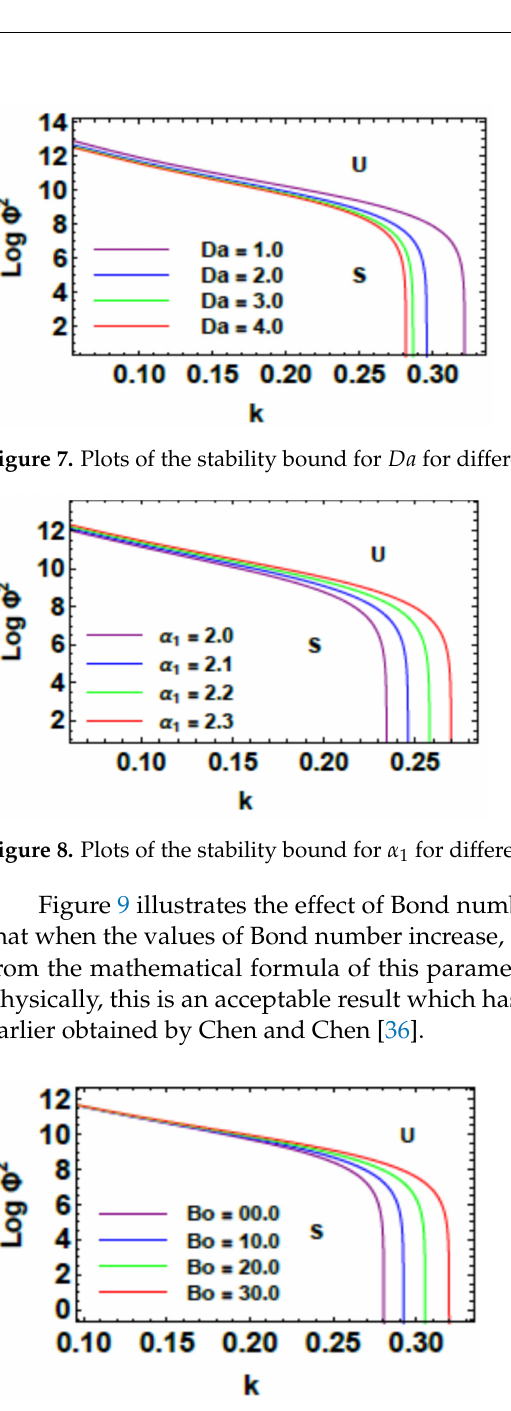
Figure 9. Plots of the stability bound for Bo for different values the parameter k versus Log Φ 2 . The velocity V represents the ratio of the velocities of the upper plate to the lower one of the suction/injection. The positive standards of V denote an injection at the permeable upper layer y = h 2 with a consistent suction at the wall y = − h 1 ; meanwhile, the